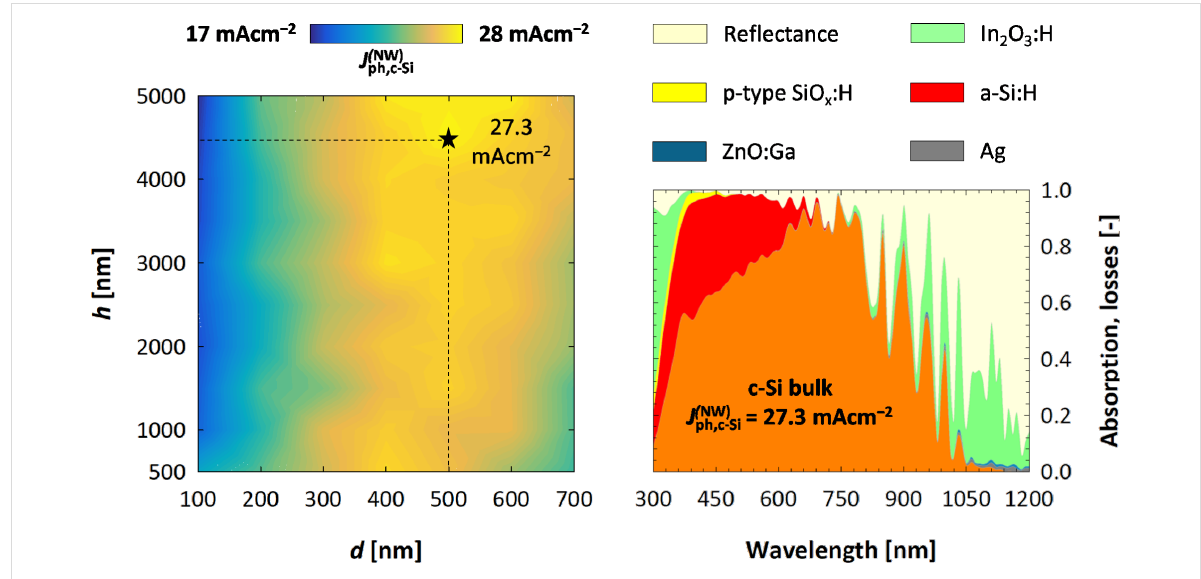
Figure 6: On the left, the implied photocurrent density generated in the c-Si absorber, as a function of cross section ( d ) and height ( h ) of the nano- wires. The maximum value ( ) is achieved for d = 500 nm and h = 4500 nm. On the right, the calculated reflection and absorp- tion in each layer of the model are plotted for the “best” structure.